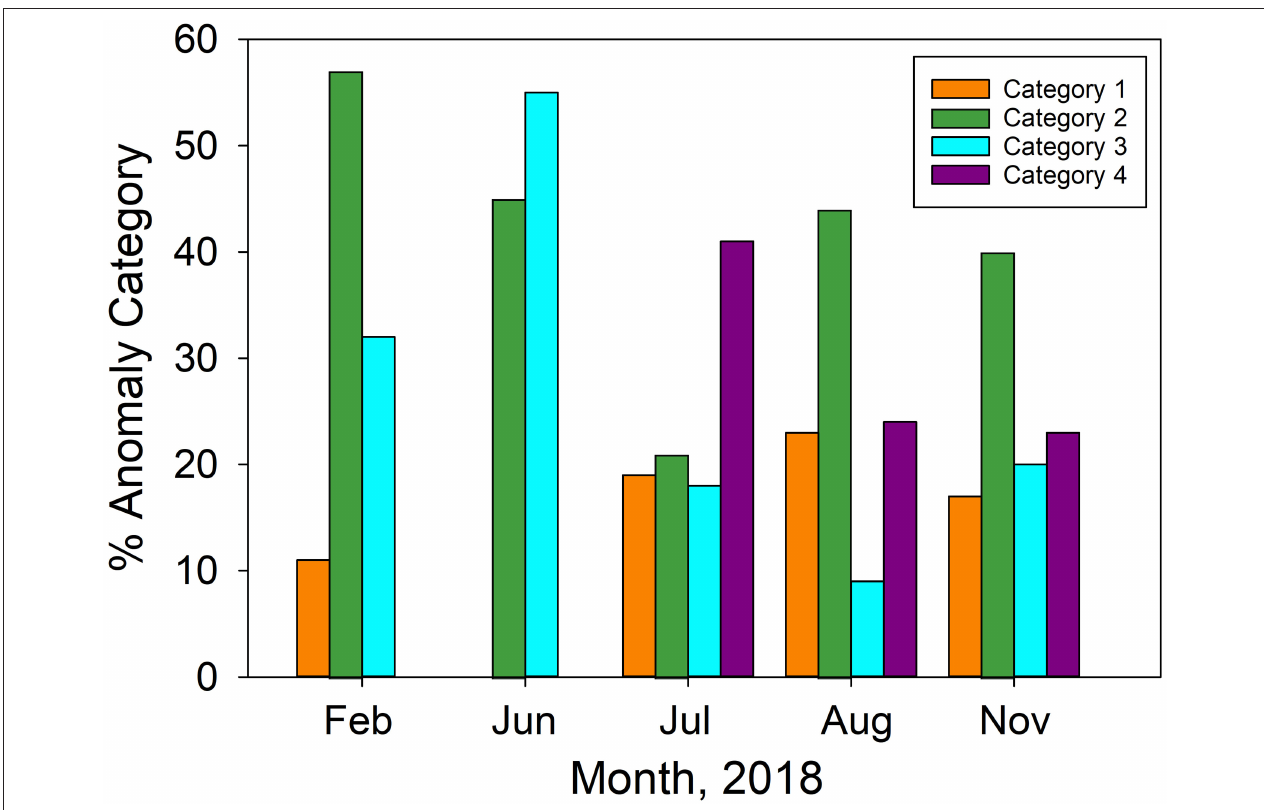
FIGURE 8 | Proportion of each anomaly type identified in each month of field campaigns in